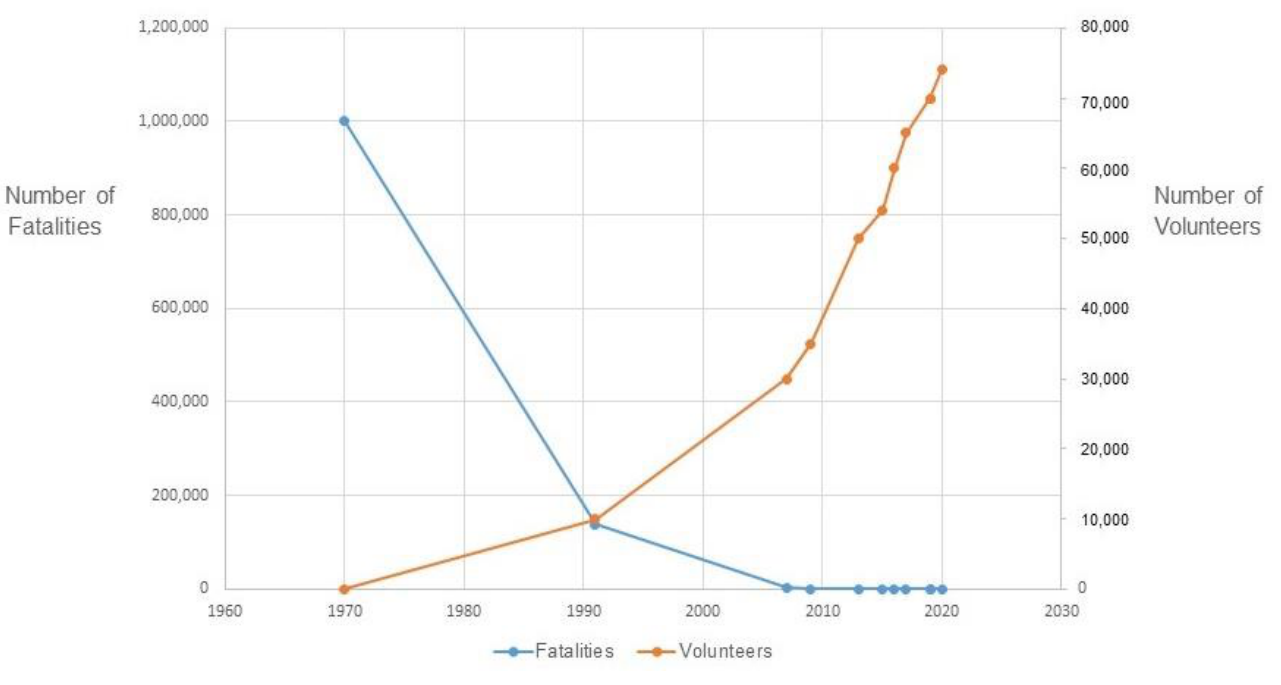
Figure 1. Historical trends in fatalities and volunteers due to tropical cyclones (Note: data for the figure was obtained from CPP, 2021c [10]).